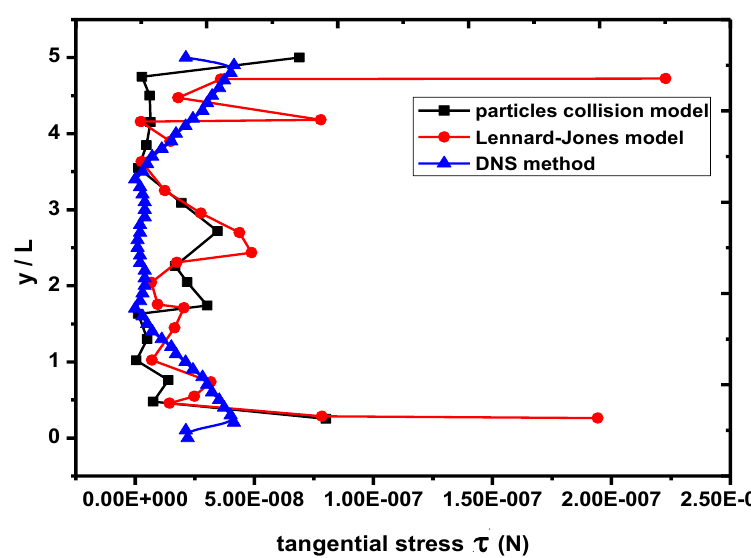
Fig. 12. the variation curves of tangential stress along the vertical centerline x/L=12.